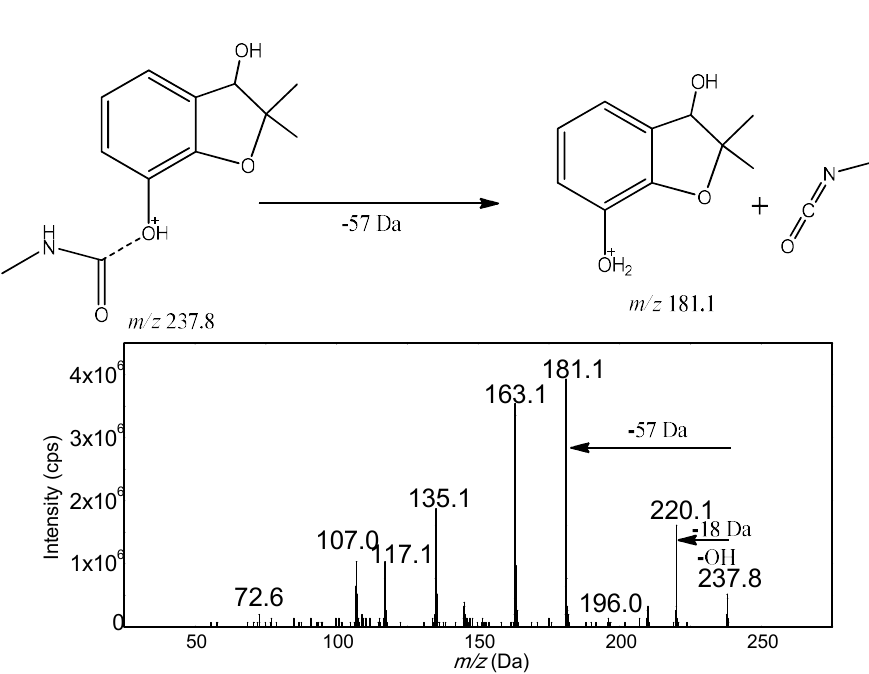
Figure 3. Product ion spectrum and probable fragmentation routes of